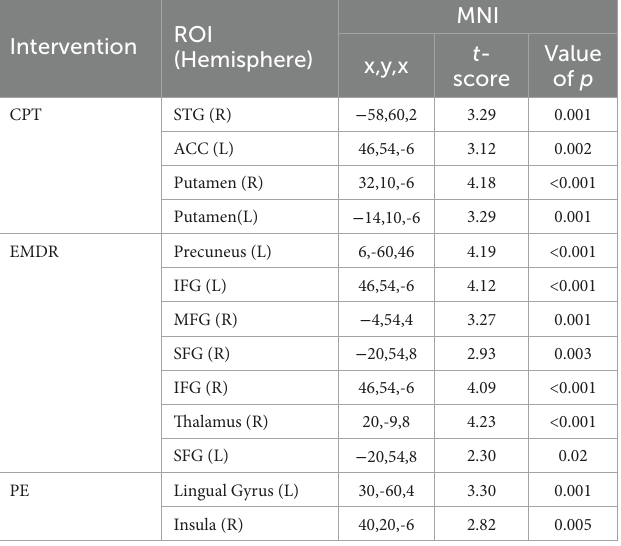
TABLE 1 Quantitative results from ALE